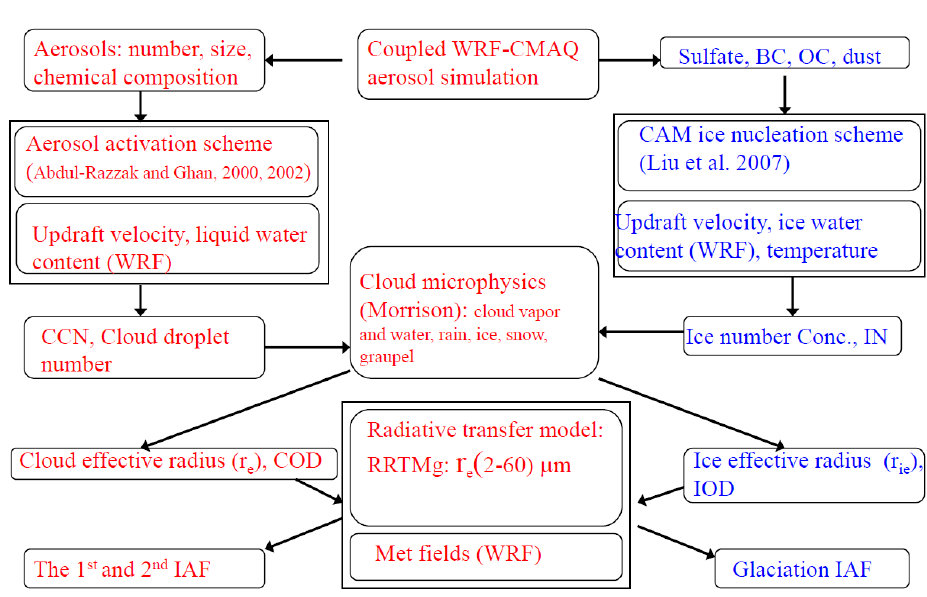
Figure 3. Flow diagram for calculation of the aerosol indirect effect (AIE) in the two-way coupled WRF–CMAQ modeling system.